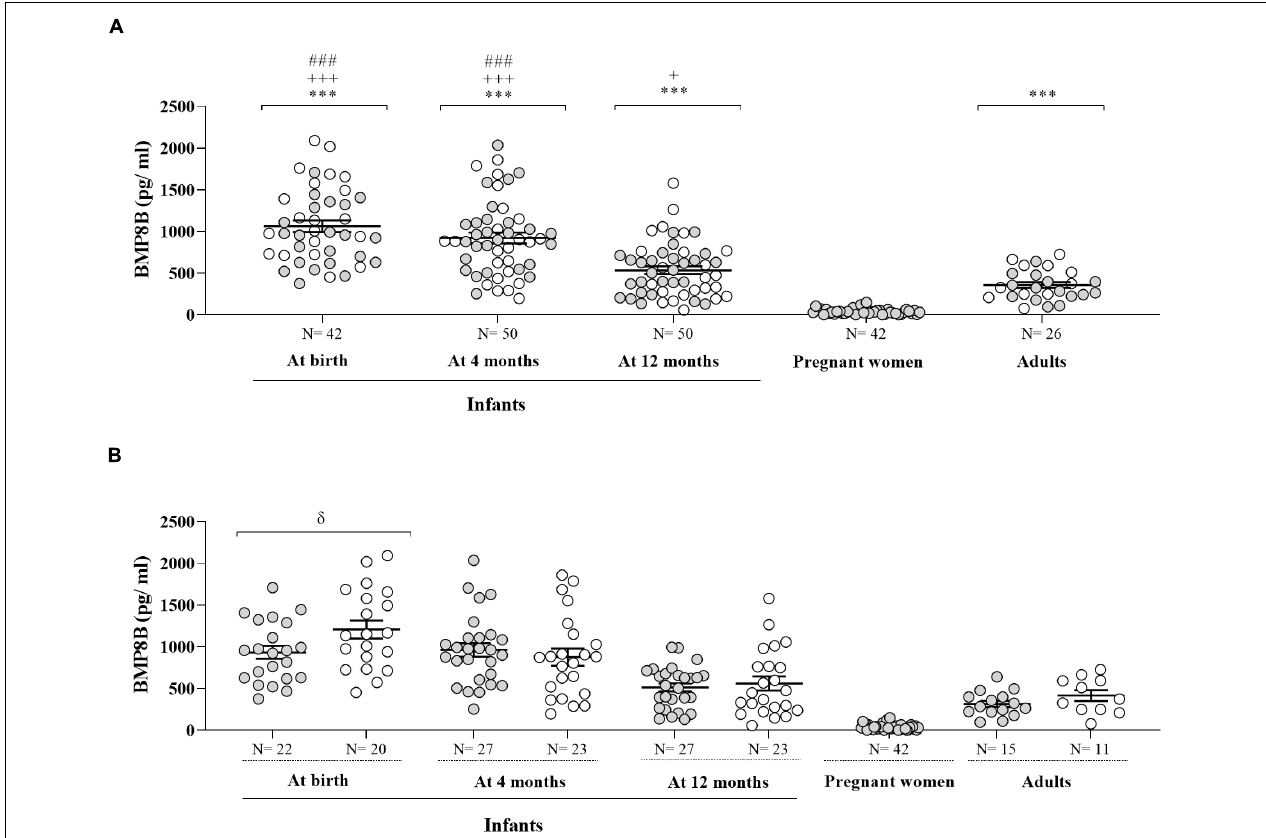
FIGURE 1 | Circulating BMP8B concentrations in human infants at birth and at age 4 and 12 months, in mothers of those infants during the third trimester of pregnancy (gestational age: 35.3 ± 0.39 weeks) and in healthy adult women and men. Data are shown for the two sexes pooled (A) and split by sex (B) . Gray dots represent girls, pregnant women and healthy adult women, and white dots correspond to boys and to healthy adult men. ∗∗∗ P < 0.001 vs. pregnant women; + P < 0.05 and +++ P < 0.001 vs. healthy adults; ### P < 0.001 vs. 12 months; δ P = 0.04 vs.